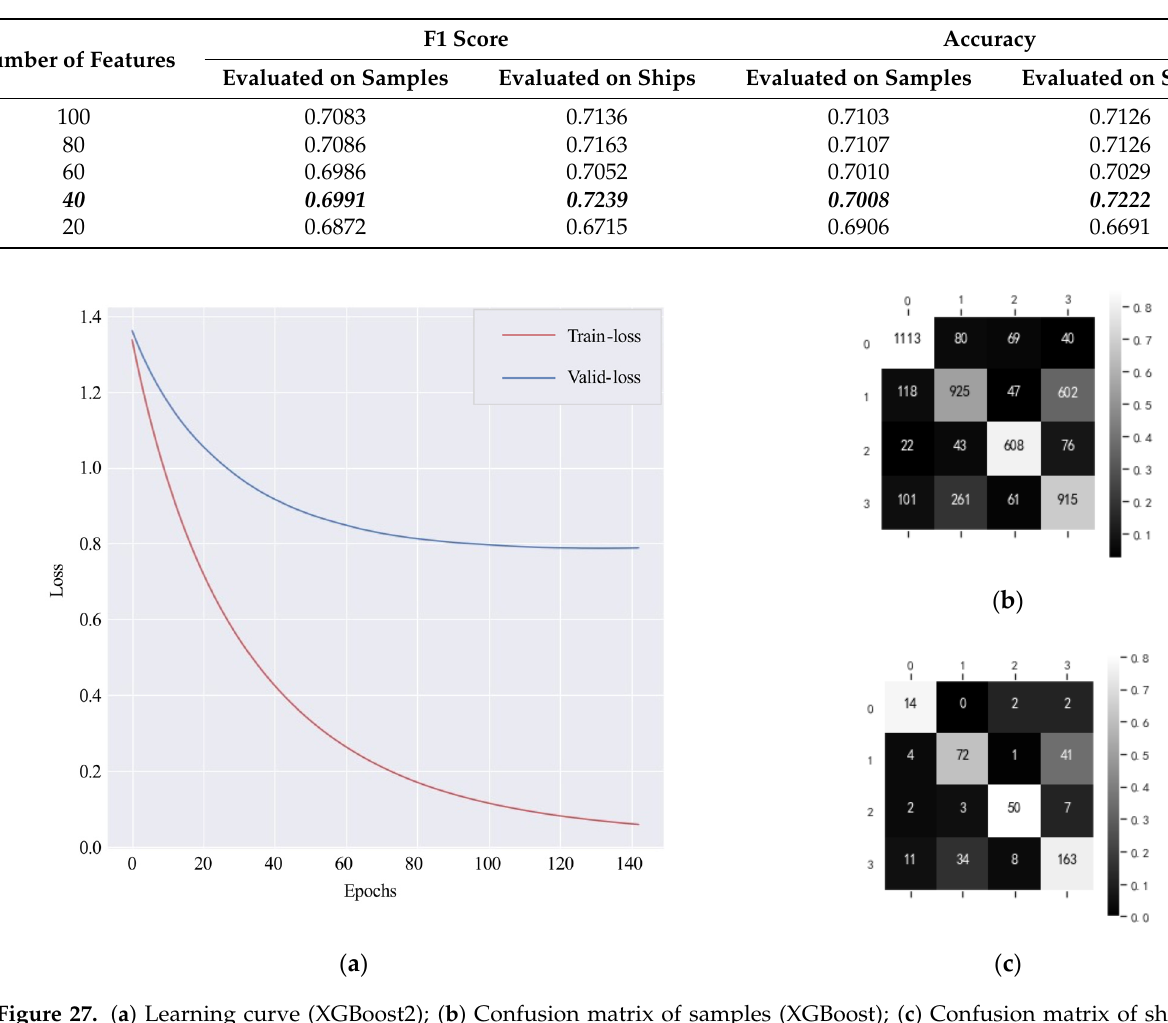
Table 12. XGBoost2 trained by different features.